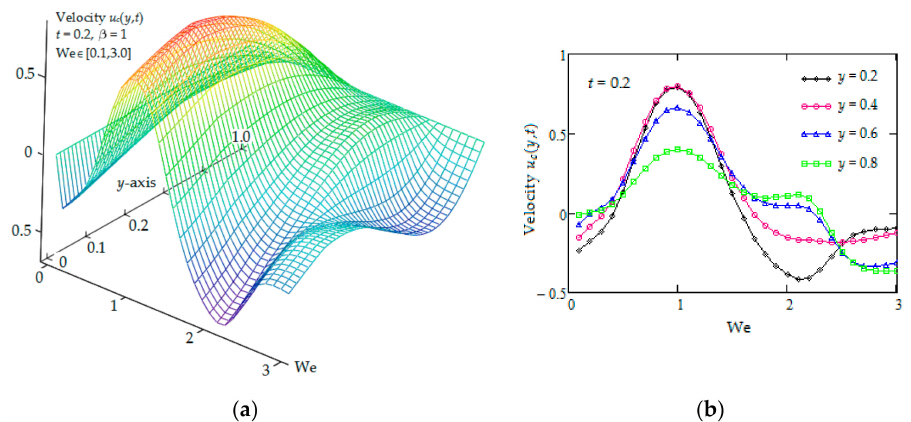
Figure 3. Spatial variation of the velocity u c ( y , t ) in the channel ( a ), and its profiles from four transversal sections ( b ), when the Weissenberg parameter belongs to the interval [0.1,